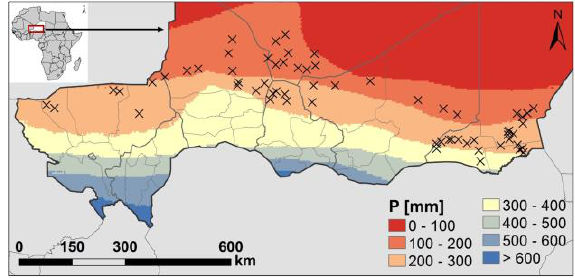
Figure 1. Biomass sample sites and mean annual precipitation